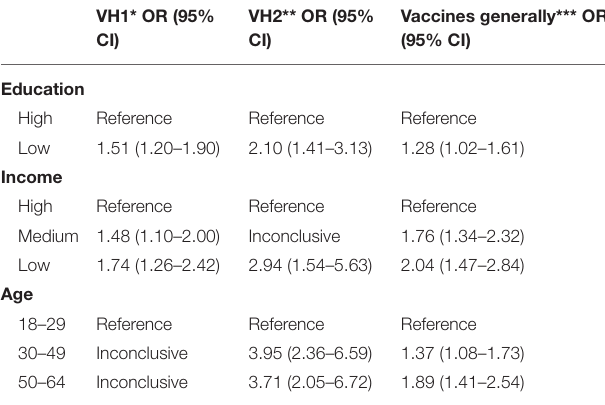
TABLE 4 | Associations between sociodemographic characteristics and HPV vaccine hesitancy (VH1; VH2), expressed as odds ratios (ORs) with 95% confidence intervals